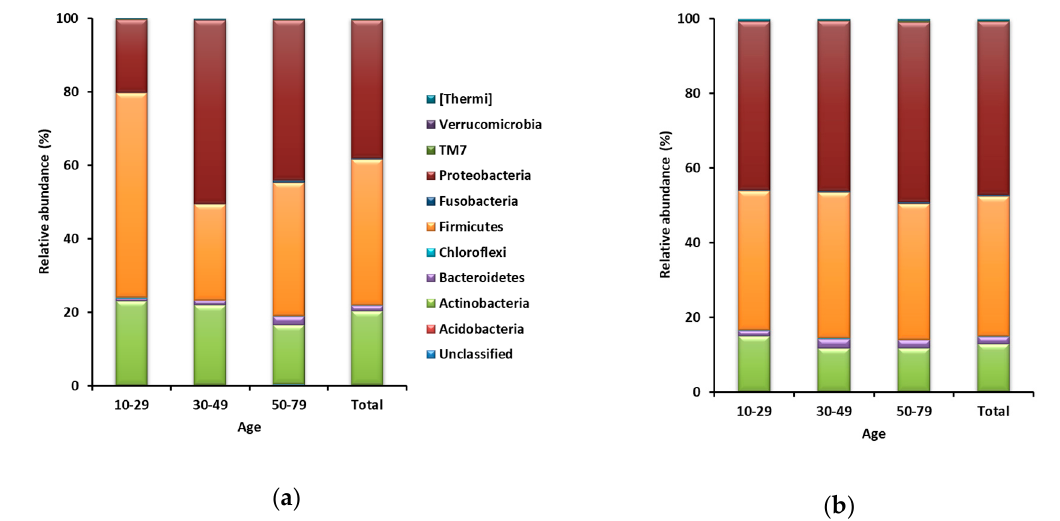
Figure 1. Relative abundances of phyla on both ( a ) forehead skin and ( b ) hand skin.